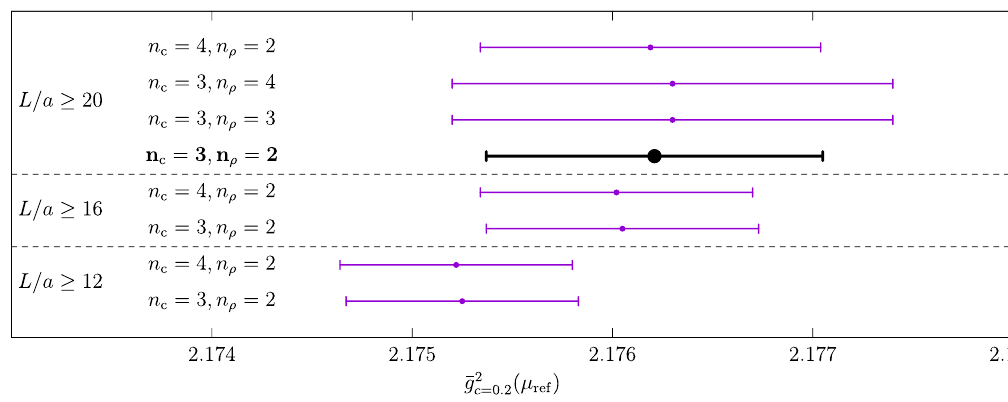
Fig. 10 Determination of ¯ g 2 defined